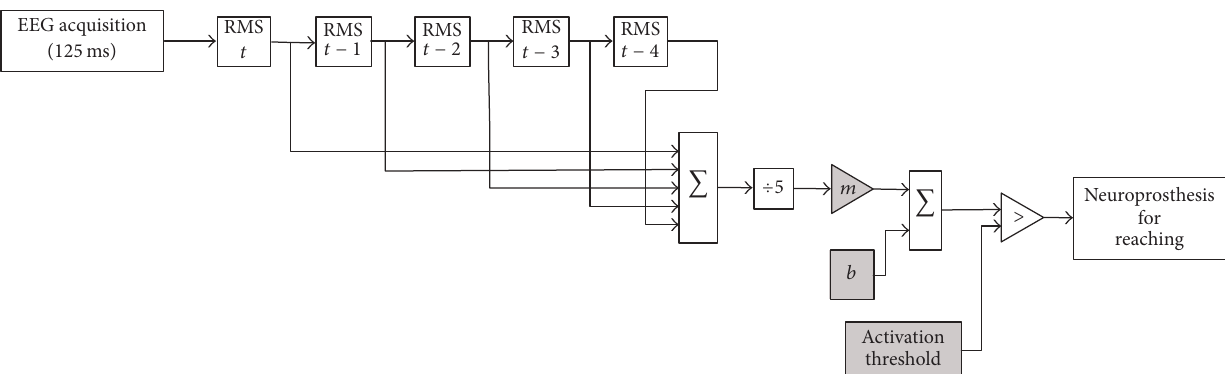
Figure 3: Implementation of the BCI. The BCI was implemented as “brain-switch” by comparing a moving average of the RMS values calculated over 625 ms decreased below an activation threshold. Elements in grey ( 𝑚 , 𝑏 , and the activation threshold) were set heuristically by one of the experimenters throughout the experimental sessions using an online display of the RMS moving average as reference. The external switch is not shown in the figure.